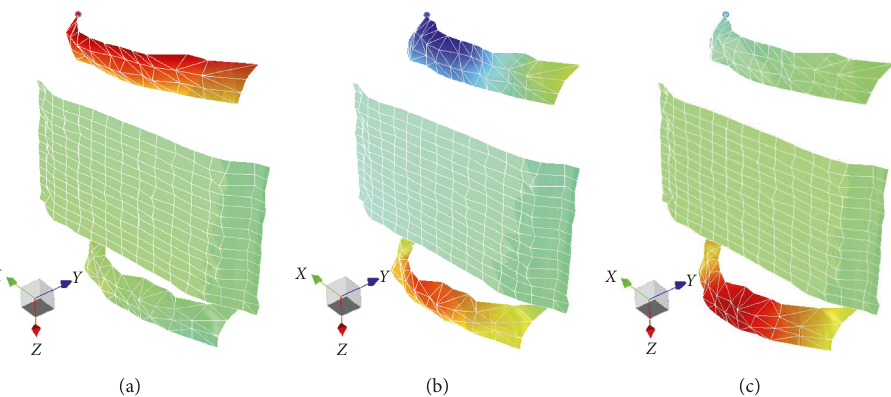
Figure 14: Experimental modal shapes of the winding for frequencies below 1000Hz: (a) ω E : 616.9Hz; (b) ω E : 728.3Hz ( x - z plane) and 819.3 Hz ( y - z plane); (c) ω E : 793.9Hz.